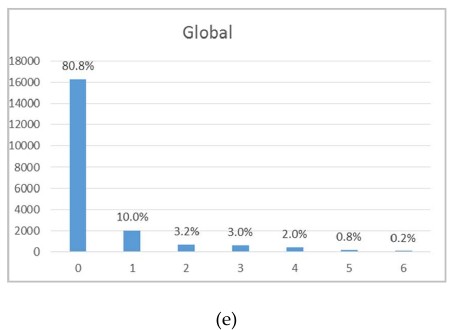
Figure A5. Borehole wolframite modal quantity histograms: ( a ) L0, ( b ) L1, ( c ) L2, ( d ) L3, and ( e ) global.